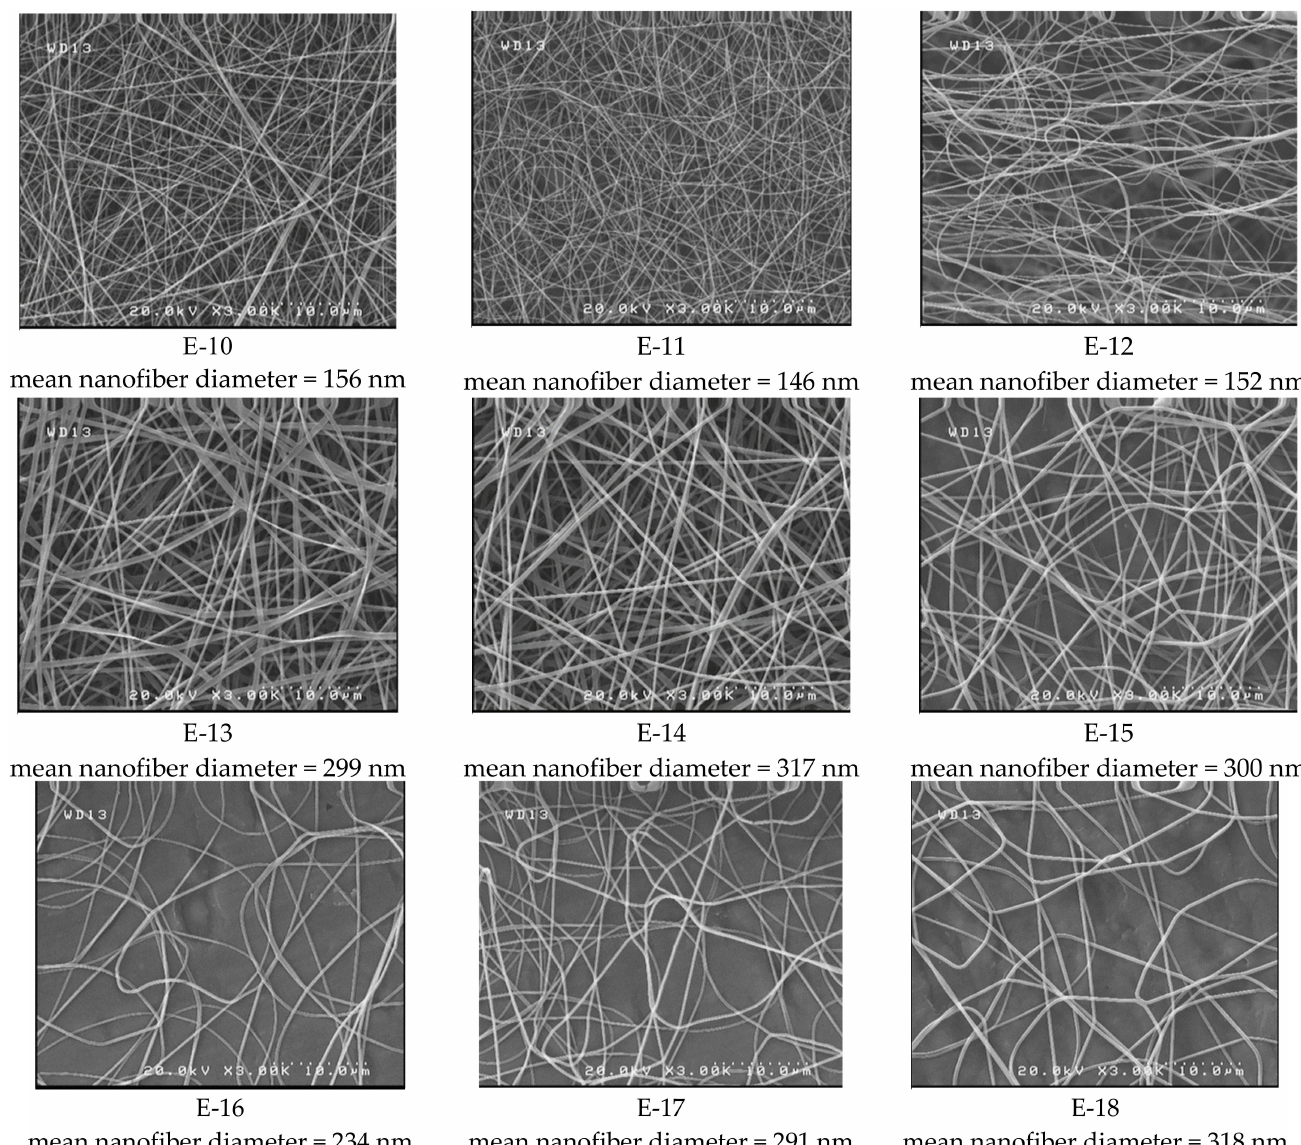
Figure 3. FEEM images of PAAm nanofibers related to experiments 10–18 of the Taguchi method. The diameters and standard deviations of the obtained nanofibers are shown in Table 2. E-27 produced the largest average nanofiber diameter (717 ± 78 nm). This PVAOH nanofiber was produced at level 3 concentration (12), level 2 distance (14), level 1 applied voltage (12), and level 3 feed rate (0.3). The type of polymer, the highest concentration of polymer solution and the lowest level of applied voltage were the main reasons for the increase in the average diameters of nanofibers. However, the average diameters of polymer nanofibers decreased drastically at E-10, E-11 and E-12, where the average diameters and standard deviations were 156 ± 18 nm, 146 ± 15 nm and 152 ± 12 nm, respectively. The polymer type, i.e., PAAm, was one of the reasons for the decrease in mean diameters in these three series. Other reasons for this were electrospinning at the lowest concentration and highest applied voltage. Table 3 and Figure 5 show the effects of polymer type, polymer solution concentration, collector-to-needle distance, applied voltage, and solution feed rate on the average diameters of electrospun